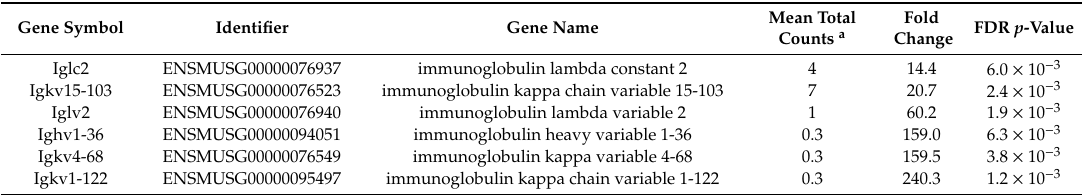
Table 6. List of di ff erentially expressed immunoglobulin chain